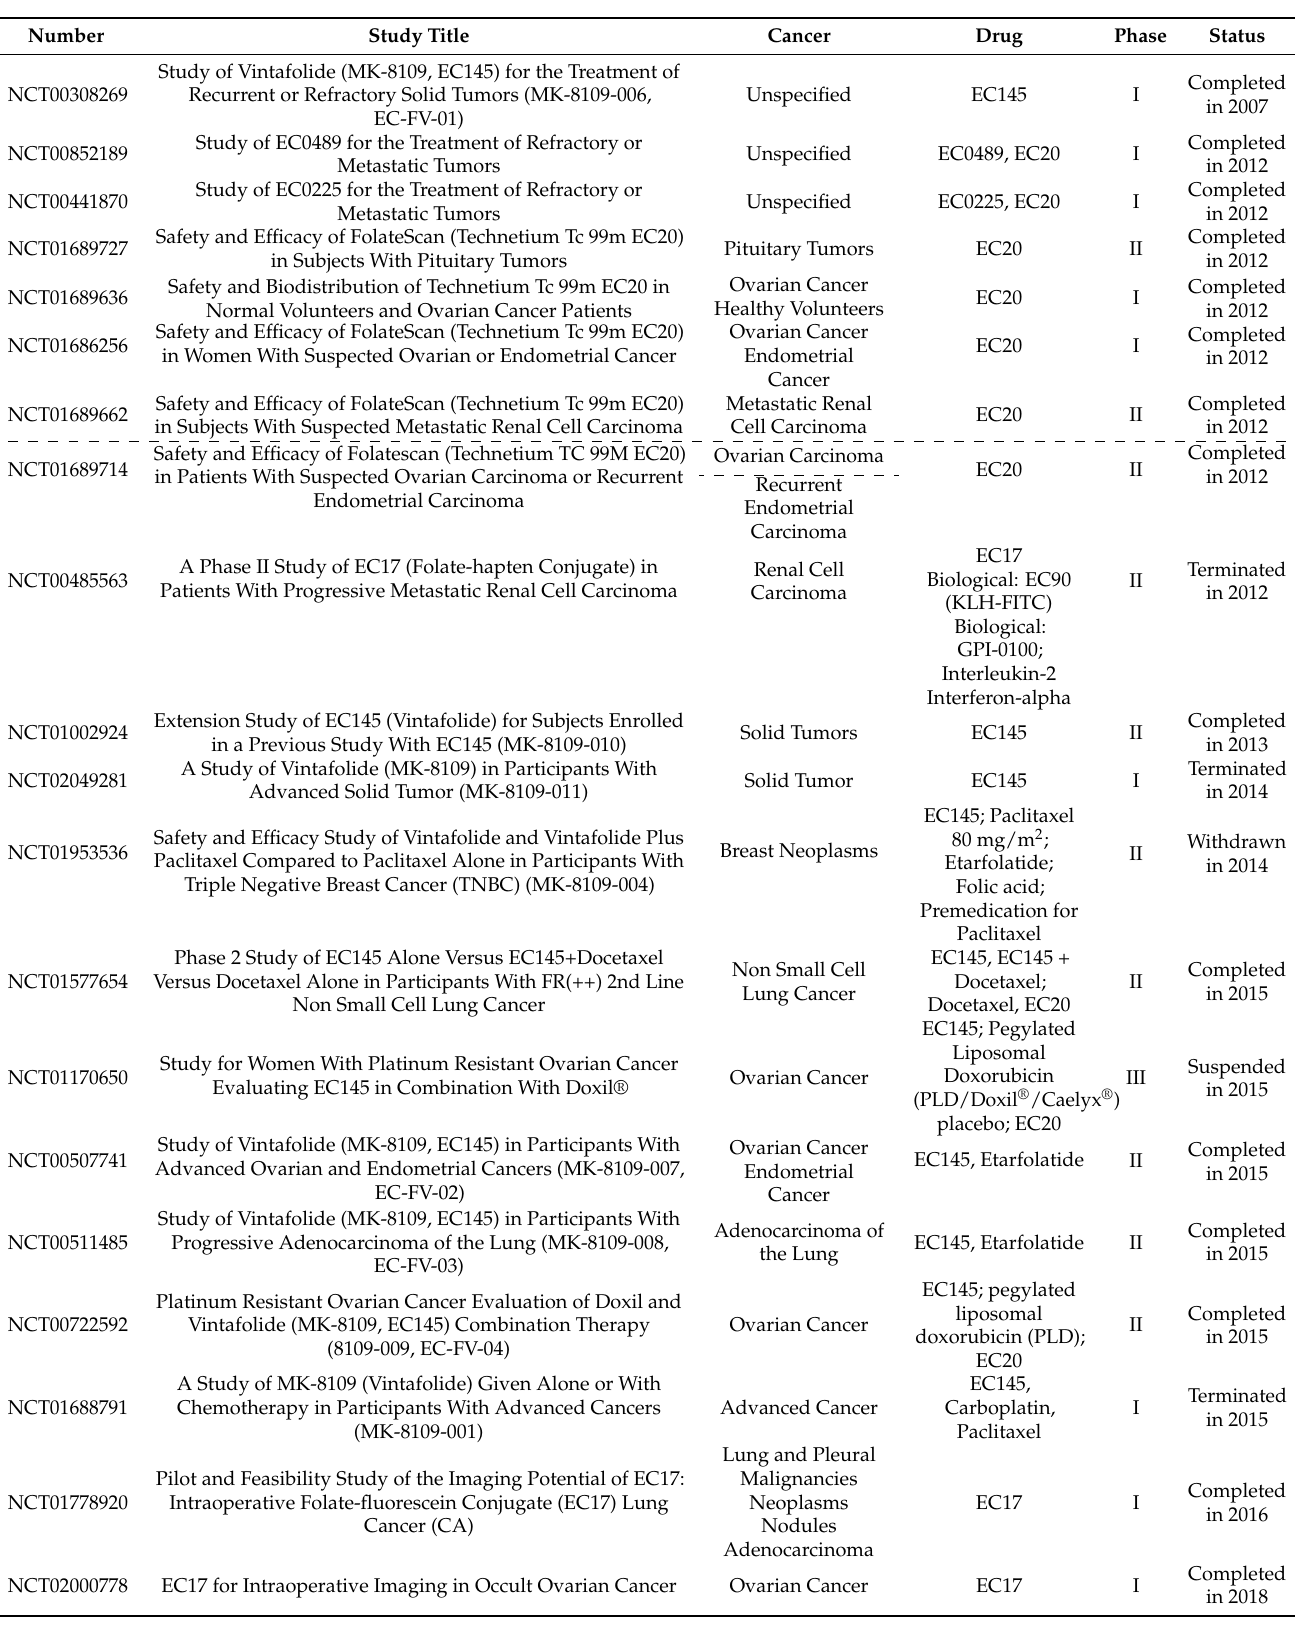
Table 2. List of clinical trials involving folic acid